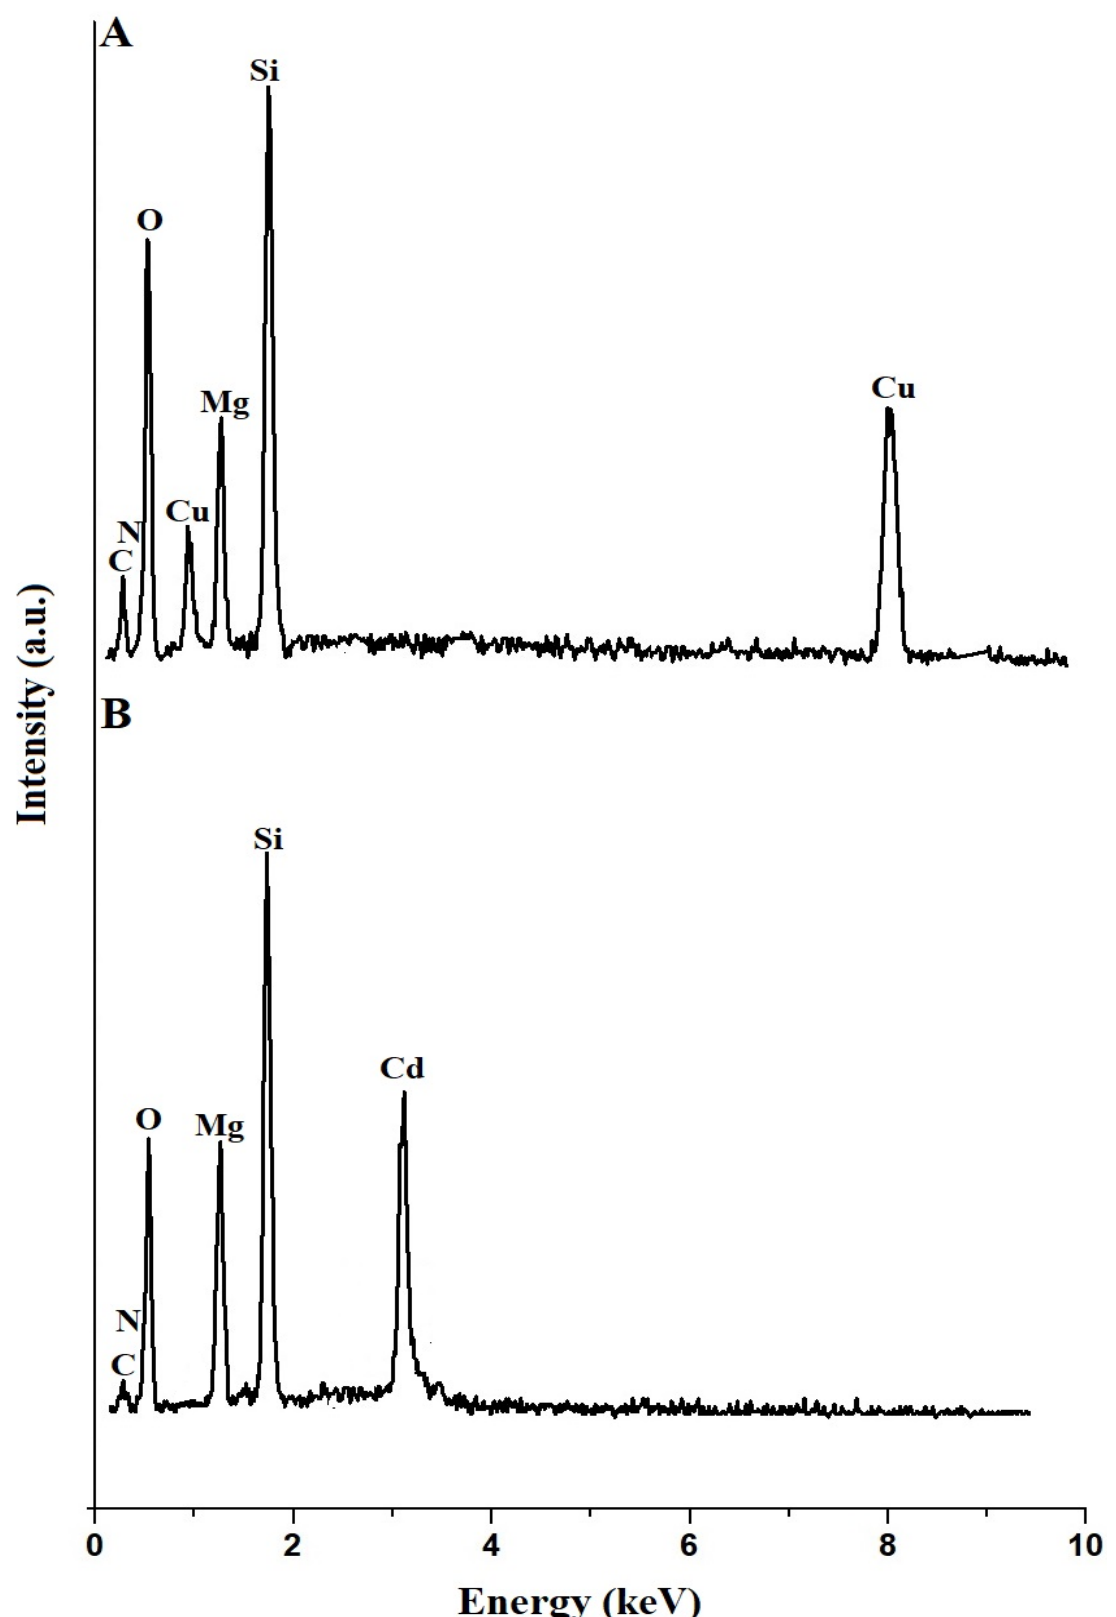
Figure 13. The EDX patterns of the Cu(II) – F1S ( A ) and Cd(II) – F1S ( B ).